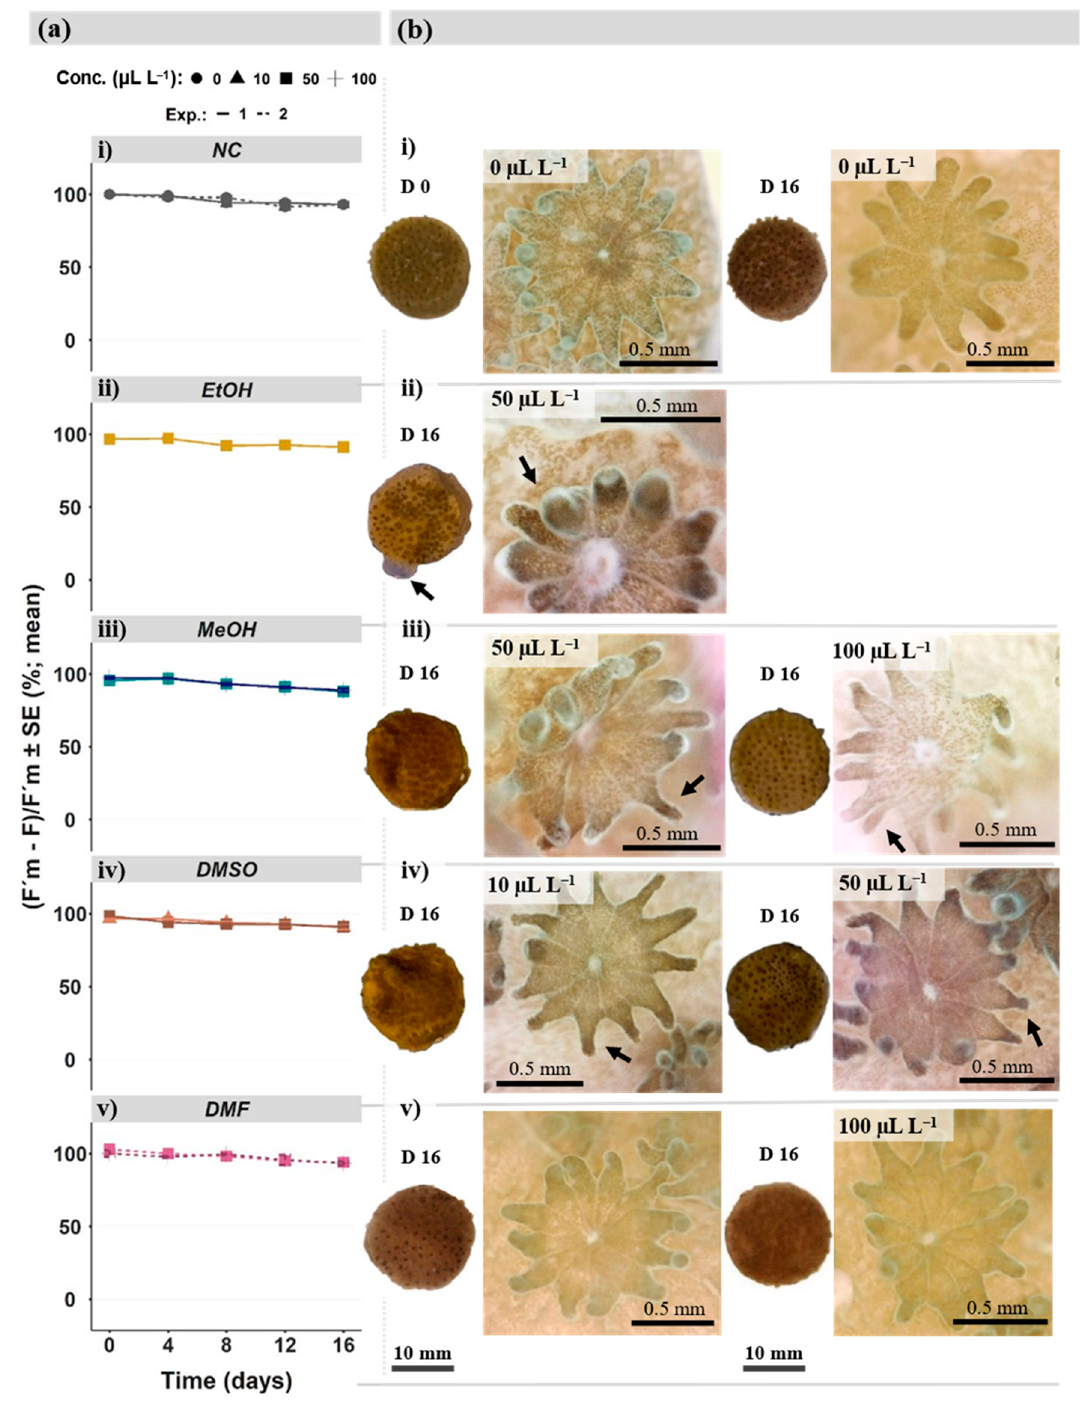
Figure 3. In ( a ), the symbionts effective photochemical efficiency of Montipora digitata are shown for 5 different time points (Day 0, 4, 8, 12, and 16) (i.e., control and solvent dose; ( i – v )). ( b ) shows the images of one fragment at the beginning ( left , D 0; 12 h after setting up the experiment) and the end of the exposure experiment ( right , D 16) of each treatment, including related polyps ( right ) from day 16. Arrows indicate abnormalities in polyp development compared to the negative control (NC).